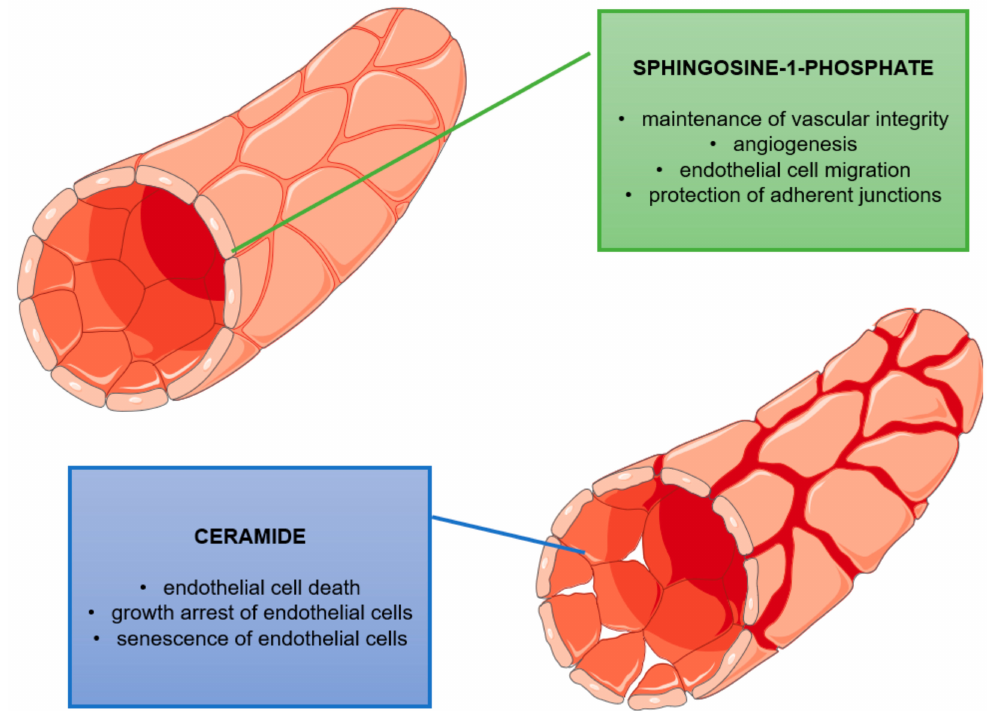
Figure 3. Role of ceramide (Cer) and sphingosine-1-phosphate (S1P) in the functions of vascular endothelium. S1P is necessary for maintenance of proper vascular integrity and promotion of angiogenesis. It is also a molecule that activate the migration of endothelial cells and protect adherent junctions. Cer is involved in programmed endothelial cell death, senescence and cell cycle arrest, leading to increased vascular permeability endothelial barrier